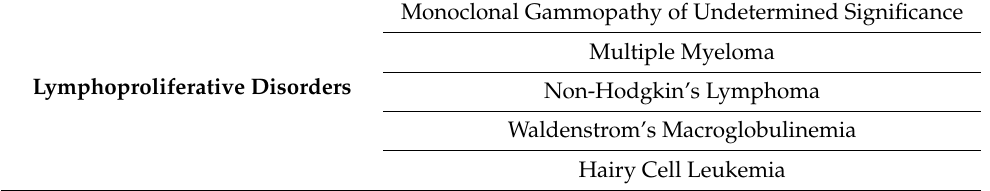
Table 1. Underlying disorders associated with acquired von Willebrand